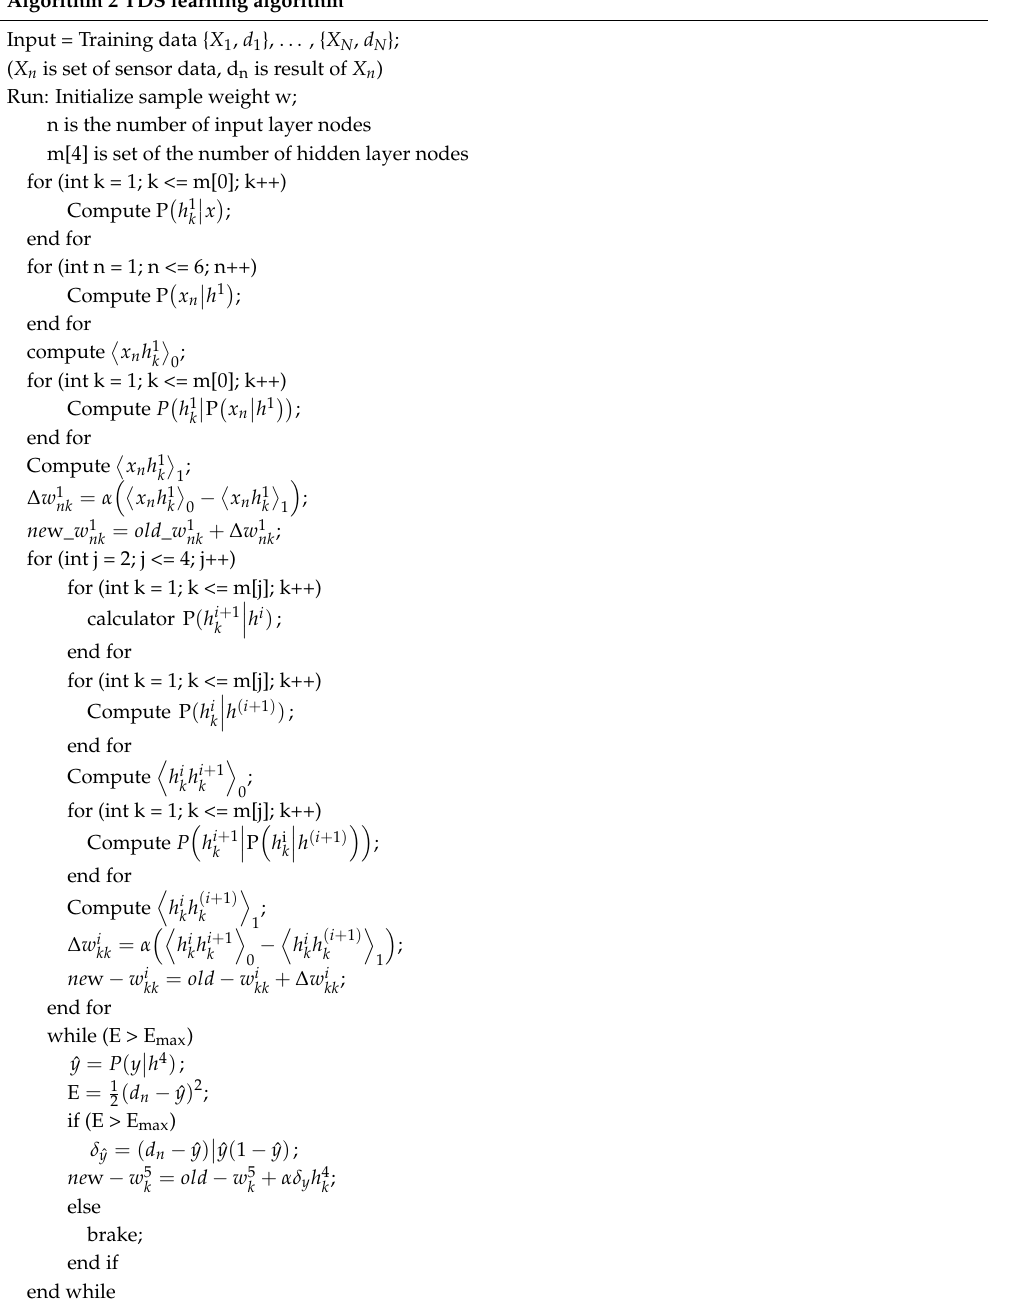
Algorithm 2 TDS learning